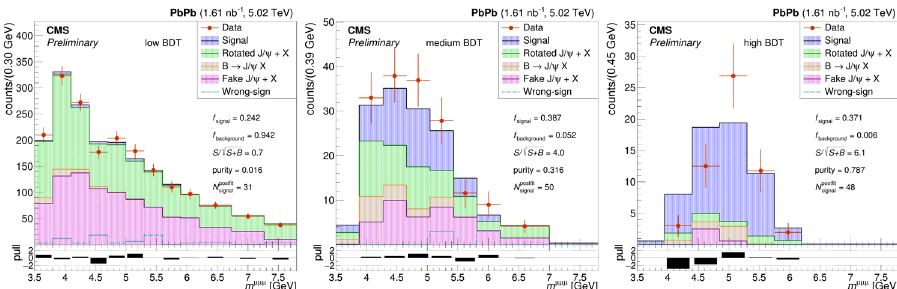
Figure 2. Template fit of the trimuon mass distributions in the three BDT bins, for the PbPb data sample integrated over the kinematic bins [20]. The pull between data and the fitted distributions is also